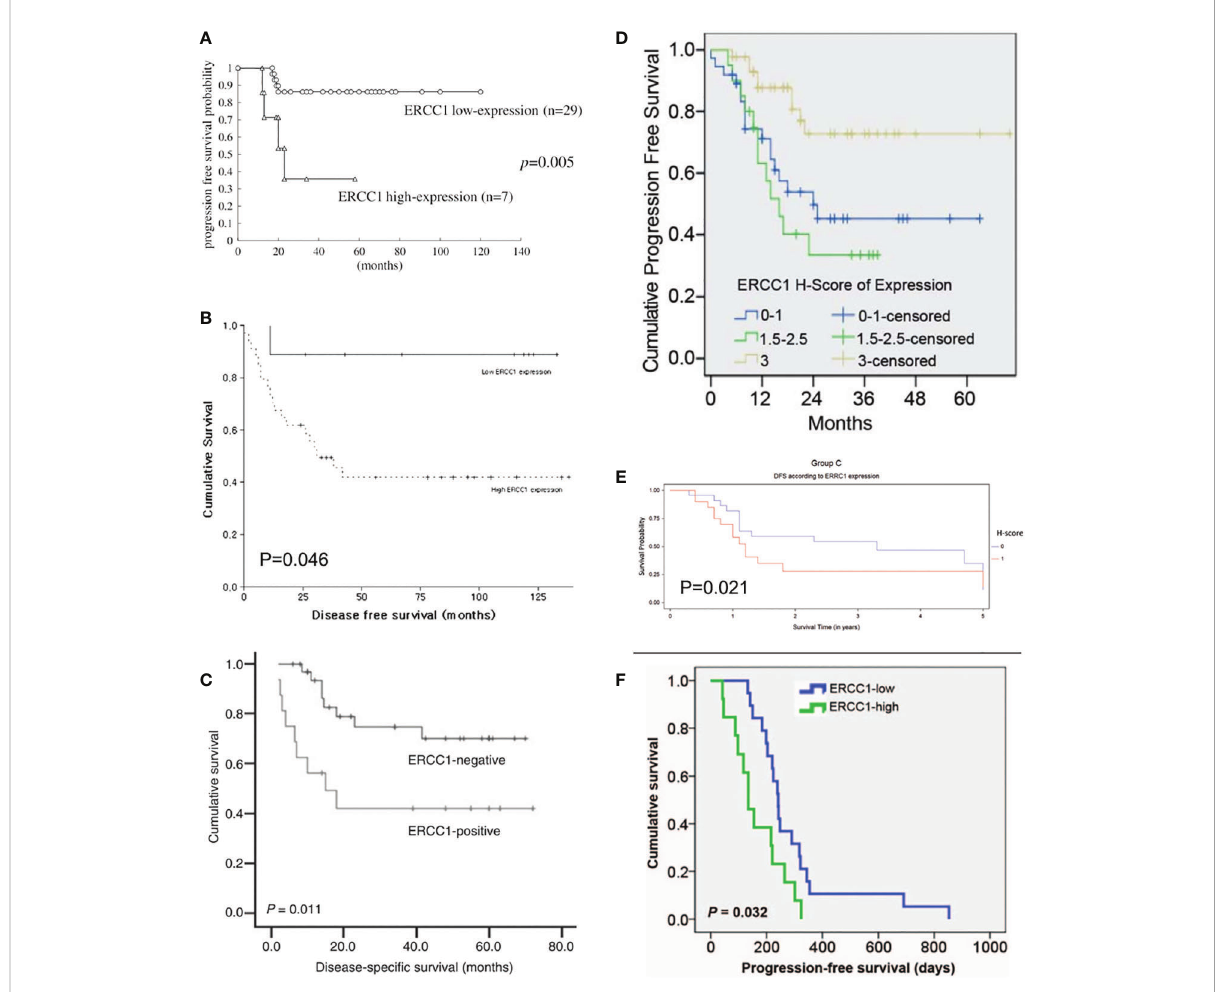
FIGURE 2 Kaplan-Meier disease-free and progression-free survival curve strati fi ed by ERCC1 status that reported in six included studies with the corresponding citation. (A) derived from the study of (25), namely A = (25); B = (26); C = (29); D = (23); E = (30); F =